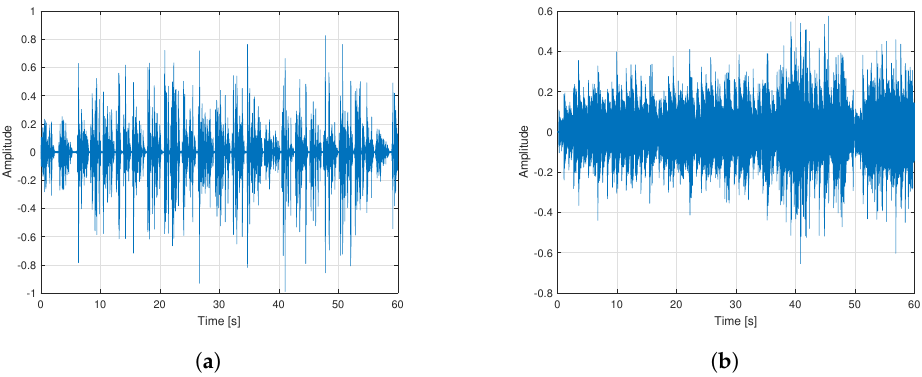
Figure 8. Incoming signals: ( a ) Concatenated speech and ( b ) music.